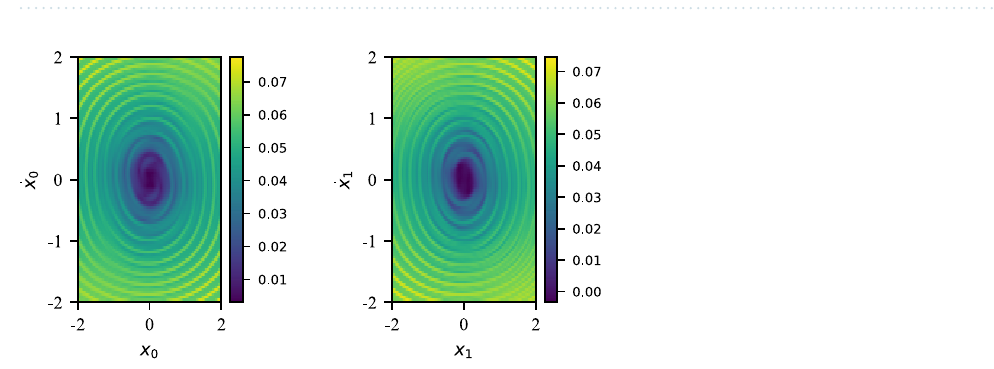
Figure 11. 2DOF duffing oscillator system.